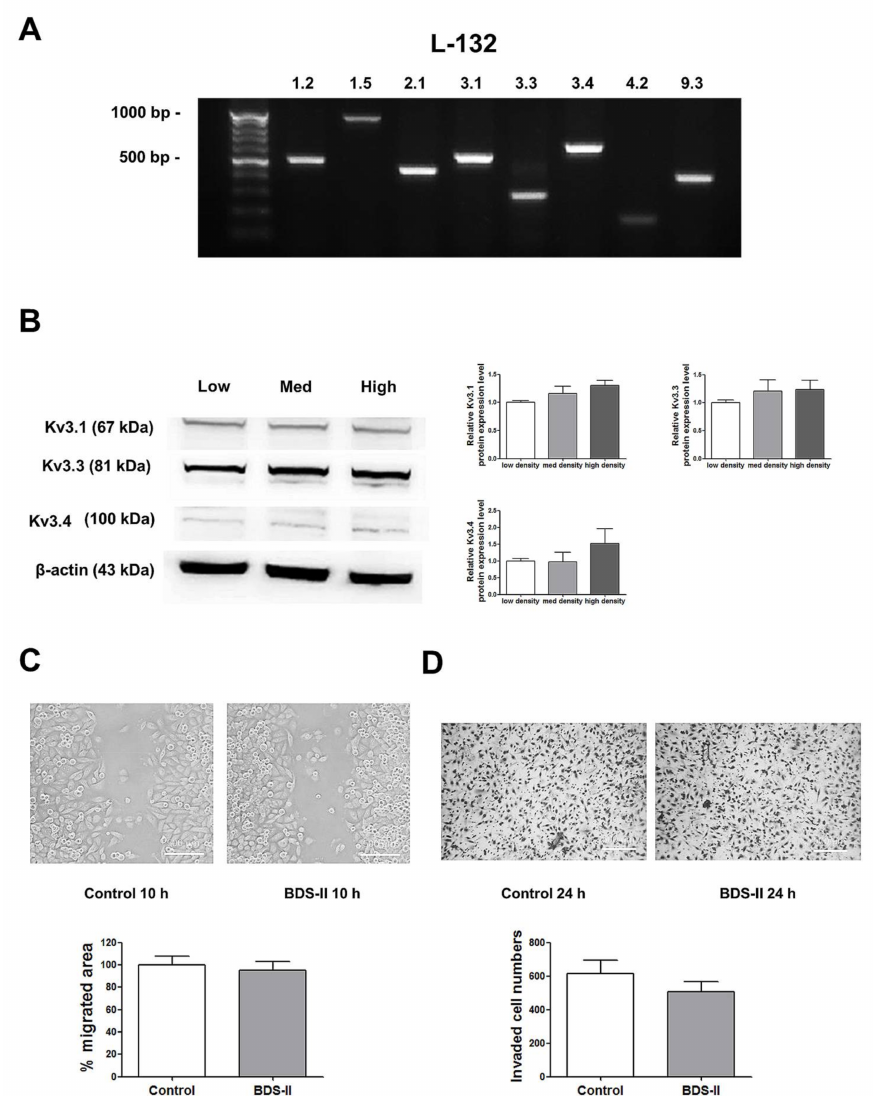
Figure 5. The expression of Kv3.1, Kv3.3, and Kv3.4 and the effect of BDS-II on L-132 cells. ( A ) RT-PCR data demonstrate that L-132 cells express all of the 8 oxygen-sensitive Kv channels at the mRNA level. ( B ) The protein expression levels of Kv3.1, Kv3.3, and Kv3.4 were analyzed by Western blot in L-132 cells. The expression of all three Kv channels was not significantly altered according to the cell density. ( C ) Representative images demonstrate that 500 nM BDS-II did not affect L-132 cell migration. ( D ) Hemacolor ® rapid staining images demonstrate that the number of L-132 cells that migrated through the membrane was not altered by 500 nM BDS-II treatment. All experiments were performed in quadruplicate, and the data represent the mean ± standard